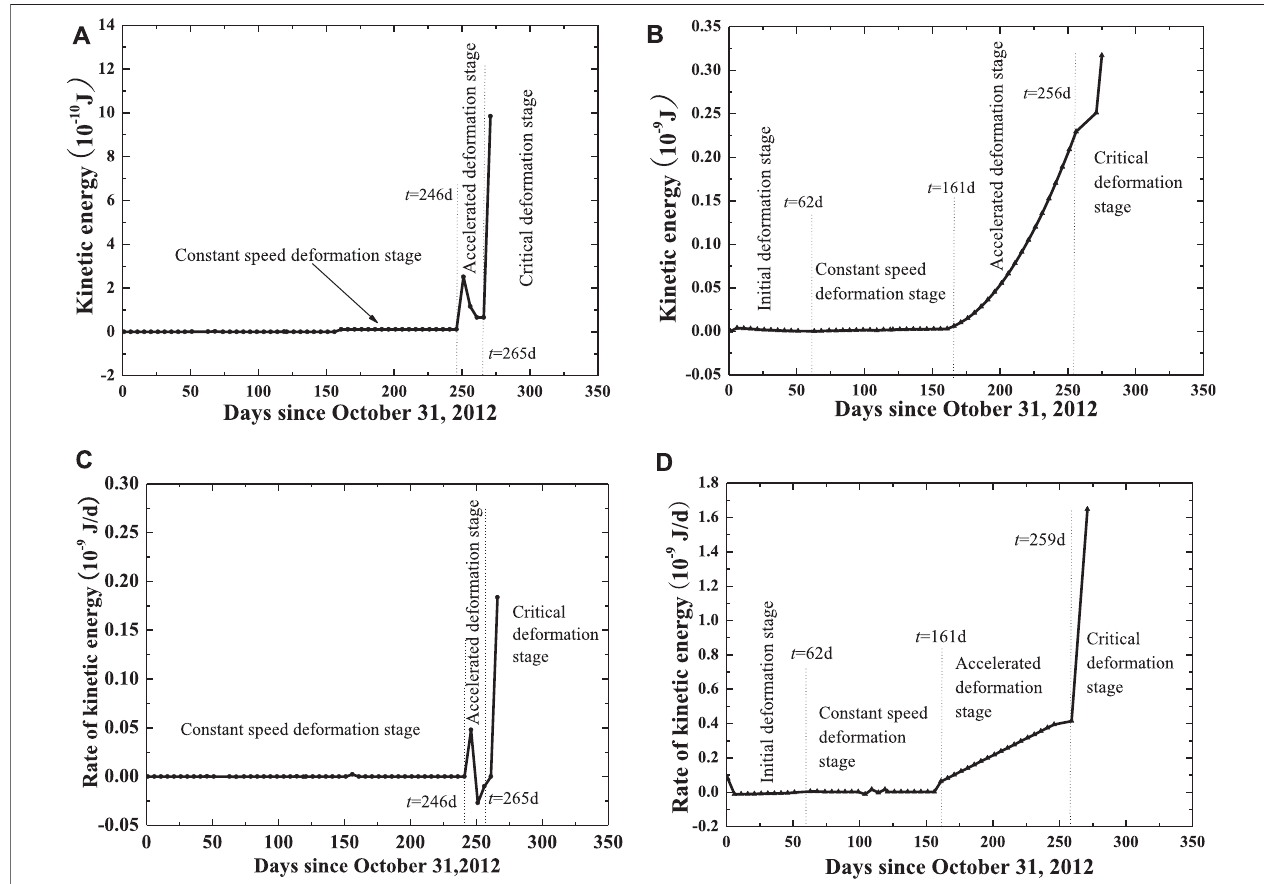
FIGURE11| Kineticenergymotionbasedonthedeepdisplacementdata:kineticenergyvstimeobtainedfrom (A) 1#SAAand (B) 2#SAA;rateofkineticenergyvs time obtained from (C) 1#SAA and (D) 2#SAA.